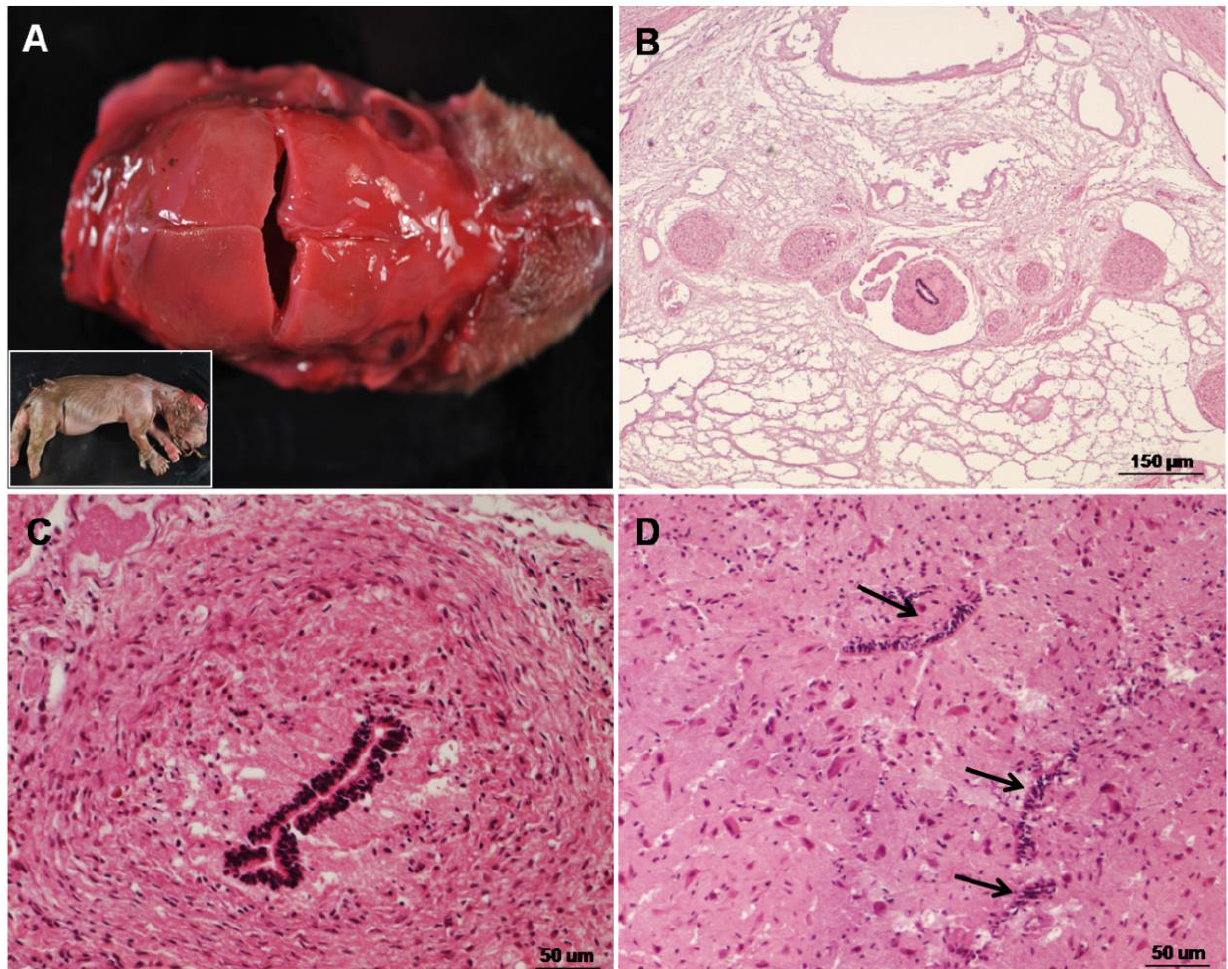
Figure 1. Gross ( A ) and microscopic ( B – D ) congenital malformations of the central nervous system in a stillborn Eurasian brown bear ( Ursus arctos arctos ): ( A ) stillborn female brown bear: Note cranium bifidum with opening of parietal and frontal bones of the skull, mainly at sutura coronalis level; ( B ) spinal cord: Severe hypoplasia and myelodysplasia are observed. Haematoxylin–eosin stain; ( C ) spinal cord: Cross-section showing a distorted canal partially lined by a pseudostratified layer of ependymal cells. Haematoxylin–eosin stain; ( D ) spinal cord: Presence of duplicated atresic central canals (arrows). Haematoxylin–eosin stain.